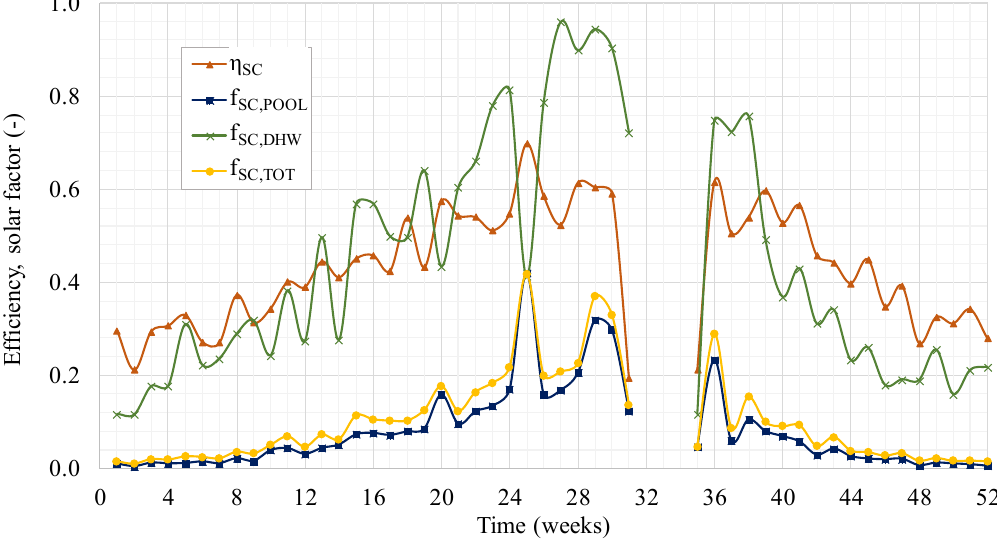
Figure 11. Efficiency of the solar collectors and solar factors for the swimming pool, domestic hot water production and total demand—evacuated tube collectors, weekly analysis.